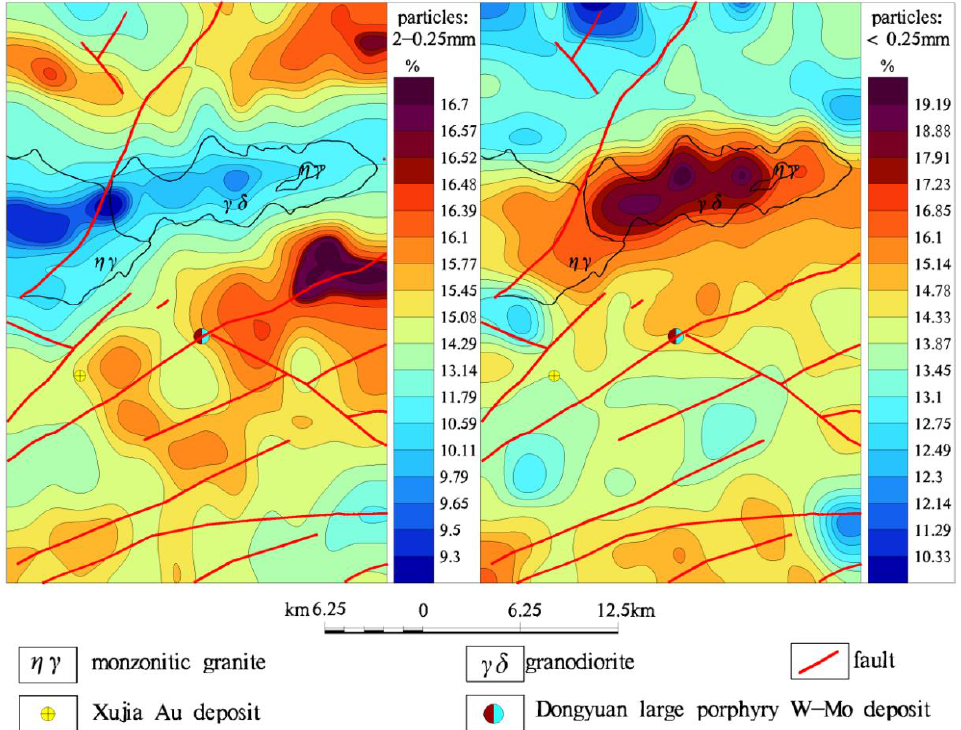
Figure 8. Geochemical maps of Al 2 O 3 in 0.25–2 mm and <0.25 mm fraction of stream sediments in the pilot area.